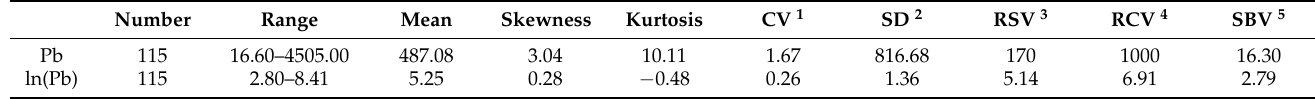
Table 1. Statistics of Pb (mg/kg) and ln(Pb) (ln(mg/kg)) for 115 soil